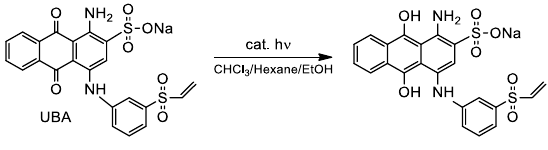
Figure 10. Effect of PEI conjugation on separation of photogenerated electron–hole pairs for TiO 2 @PEI-MWCNTs nanocomposite.